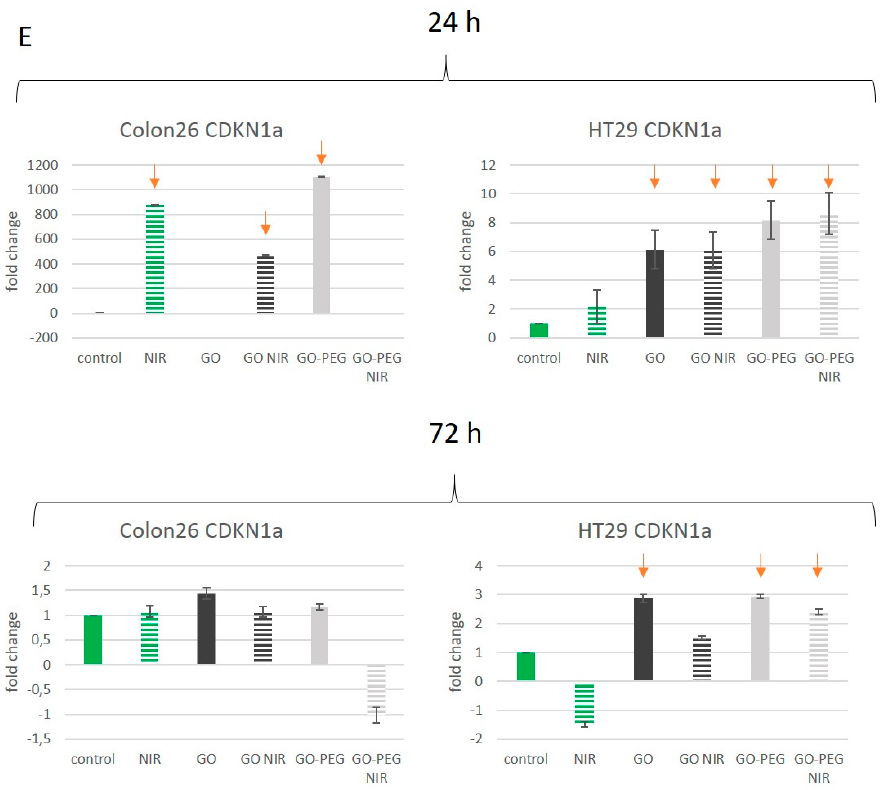
Figure 9. RT-qPCR for studying the effect of PEGylated GO nanoparticles with near-infrared laser irradiation on the activity of stress-responsive genes in colorectal carcinoma cells. ( A ) Fold change in the expression of the ATM gene. ( B ) Fold change in the expression of RAD51 ( C ) Fold change in the expression of TP53 ( D ) Fold change in the expression of BCC3 (PUMA) ( E ) Fold change in the expression of CDKN1A (p21) Three repetitions of the experiment were conducted and values represent the fold change in the expression of the studied genes as MEAN ± STDV. Red arrows denote significant alterations in the activity of certain genes after GO NPs treatment with and without NIR irradiation.